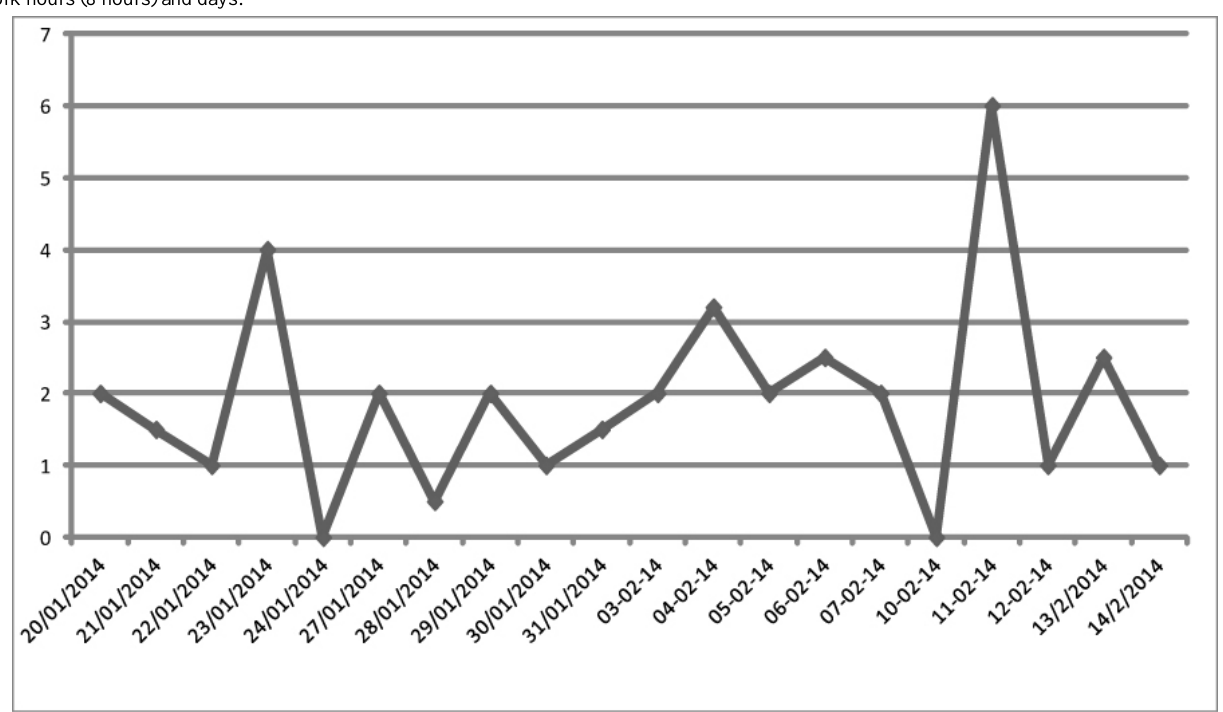
Figure 4. The average daily power interruption rate in the four hospitals of Addis Ababa (January-February, 2014). Fluctuations were measured during work hours (8 hours) and days.